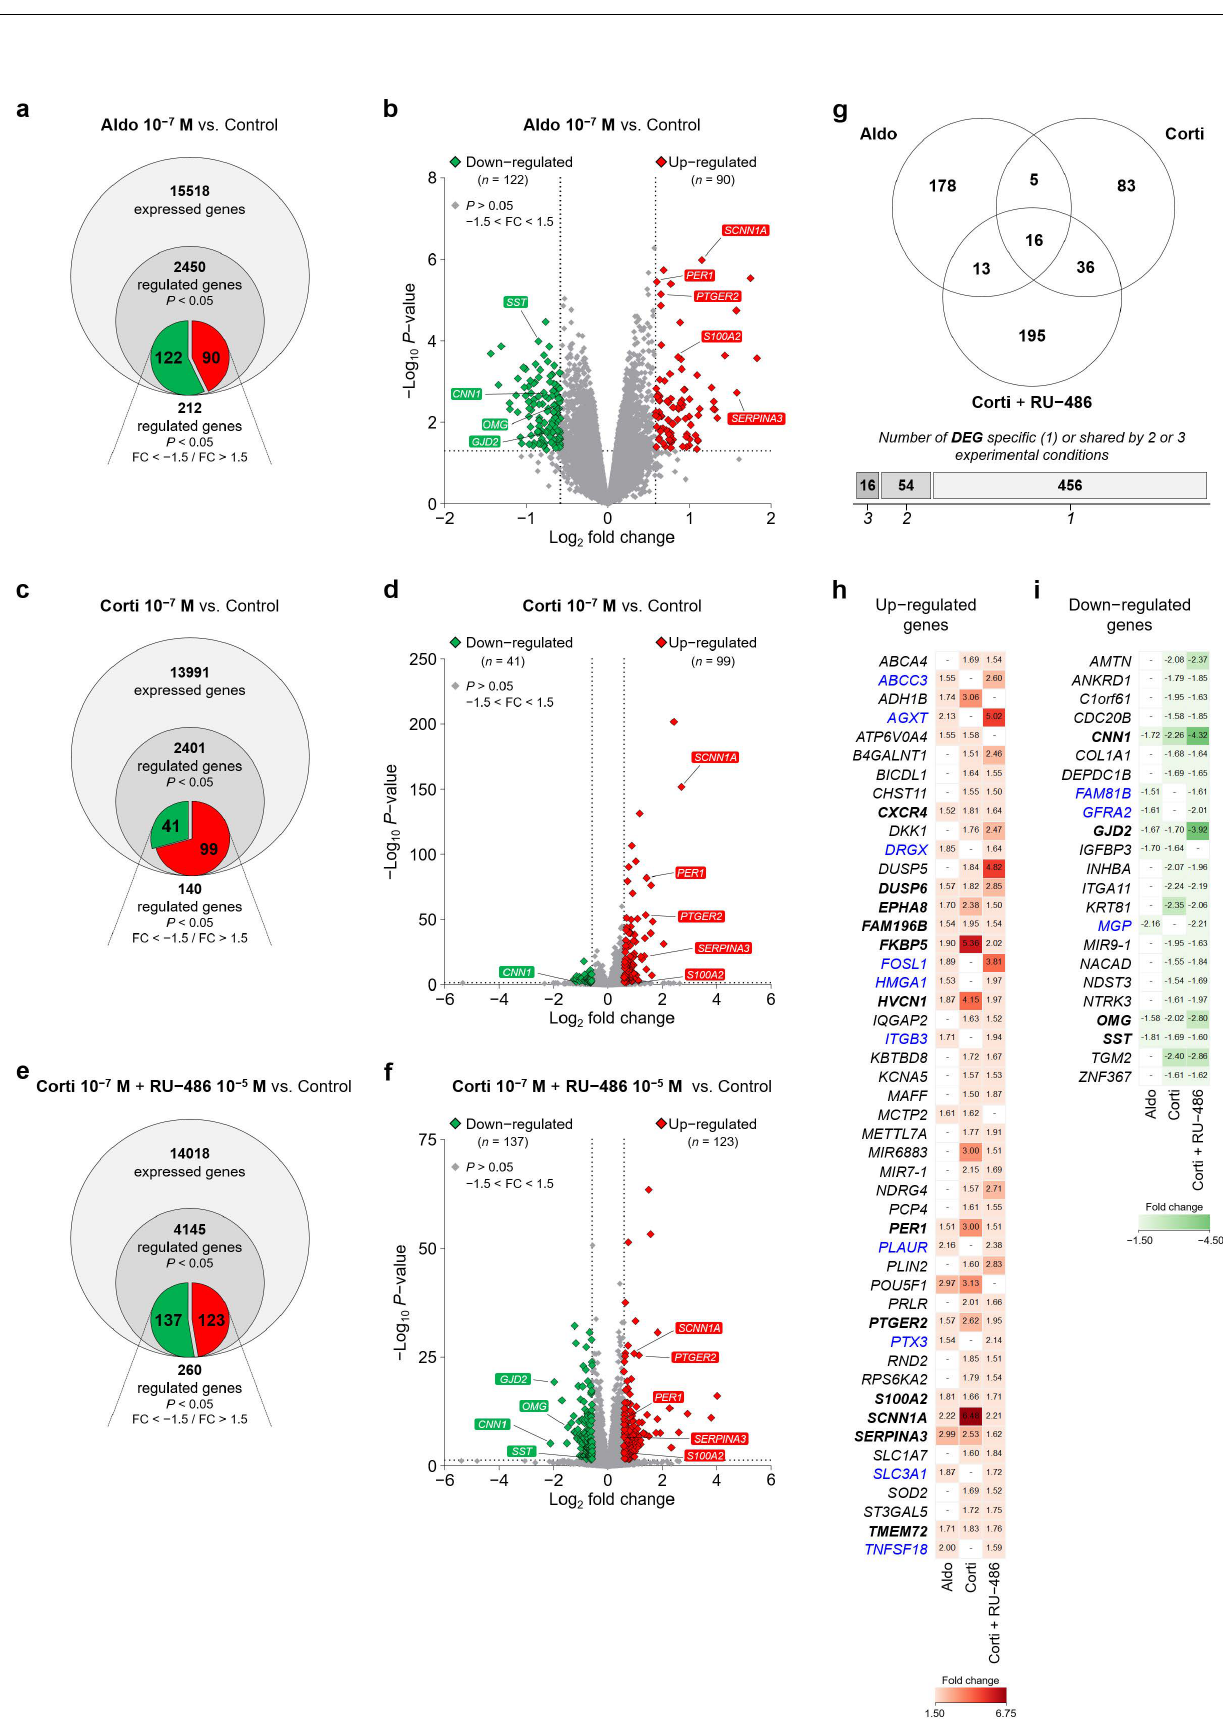
Figure 4. RNA-Seq transcriptome analysis identified corticosteroid-regulated genes in iRPE cells. ( a ), ( c ) and ( e )